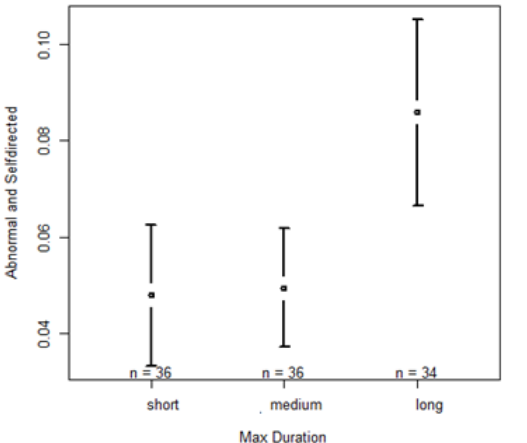
Figure 4. Confidence interval plots of abnormal and self-directed behaviors and the fixed effect duration of the longest event (max duration).